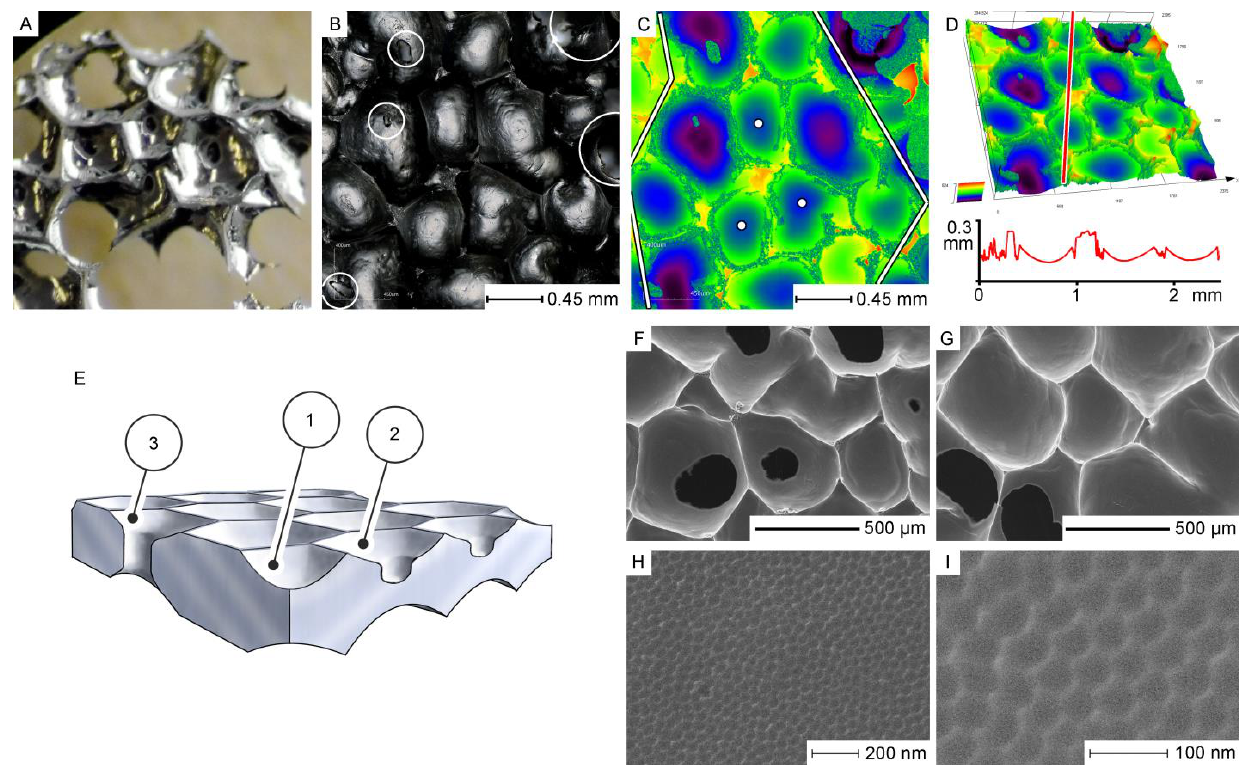
Figure 34. Formation of hierarchical anodic textures on aluminum (in one step using a 0.3 M H 2 SO 4 solution at 40 °C) demonstrates a complex and multiscale nature of chaotic electroconvection. Polygonal sub-millimeter pores on the upper hierarchy level ( A – G ) have either hemispherical (labeled as 1 in the schematic diagram ( E )) or funnel-shaped ( 2 and 3 in ( E )) bottoms, and a tendency to hexagonal coordination (see the optical microscopy image in ( B ) and the corresponding pore topography measurements obtained by the non-contact 3D visualization method in ( C ) and ( D )). The cells inside the boundary in ( C ) are hexagonally packed (every pore surrounded by six nearest neighbors is marked with a white dot). High-resolution SEM images ( F – I ) reveal a hierarchical structure in which two honeycombs with cell sizes differing by a factor of 10 4 are superimposed. Reproduced with permission from [54]. Copyright 2020 The Royal Society of Chemistry.